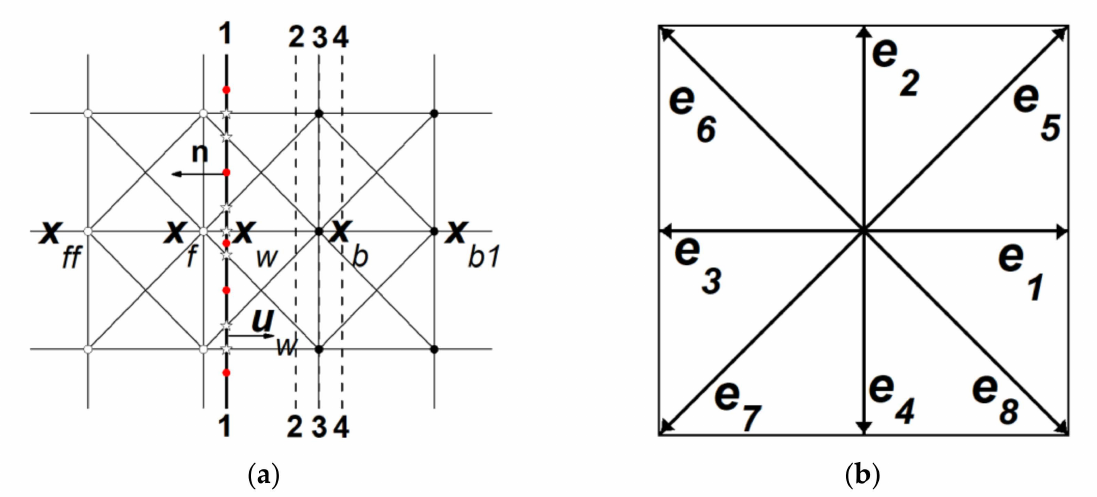
Figure 1. ( a ) Schematic diagram of the movement boundary; ○ , fluid grid points; ● , solid grid points; ● , the points that make up the boundary; ☆ , the intersection points of the solid boundary and the intersecting grid; the solid black line is the solid boundary curve; 1-1, 2-2, 3-3, and 4-4 are fixed positions respectively; ( b ) Schematic diagram of discrete velocity of D2G9 model.